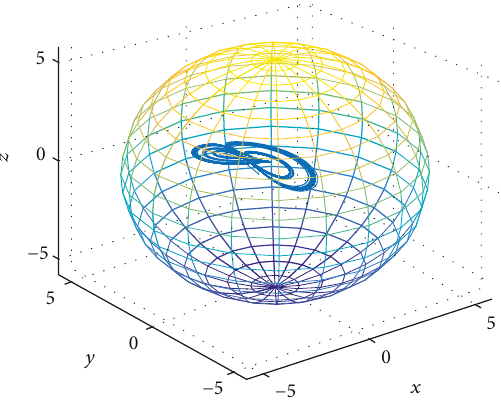
Figure 1: The chaotic attractor of system (2) in xOyz space with a = 0 9 , b = 0 2 , c = 1 5 , d = 1 , k = 0 05 , m = 0 005 , and x 0, 1, … , 0 5, 0 .